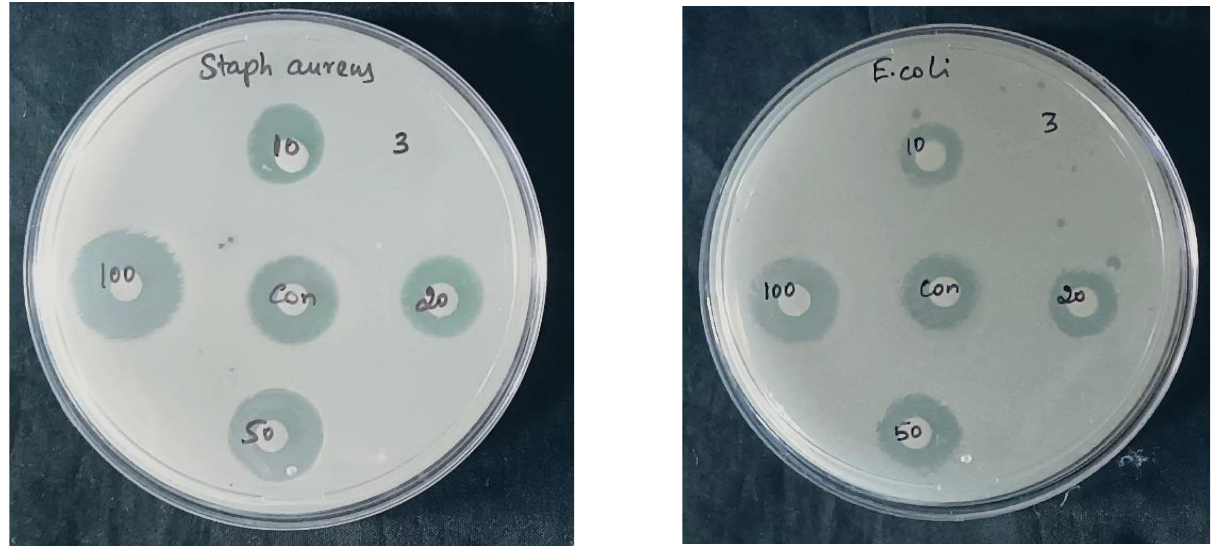
Figure 9. Antibacterial activity of biosynthesized ZrO 2 NPs against S. aureus and E.coli.